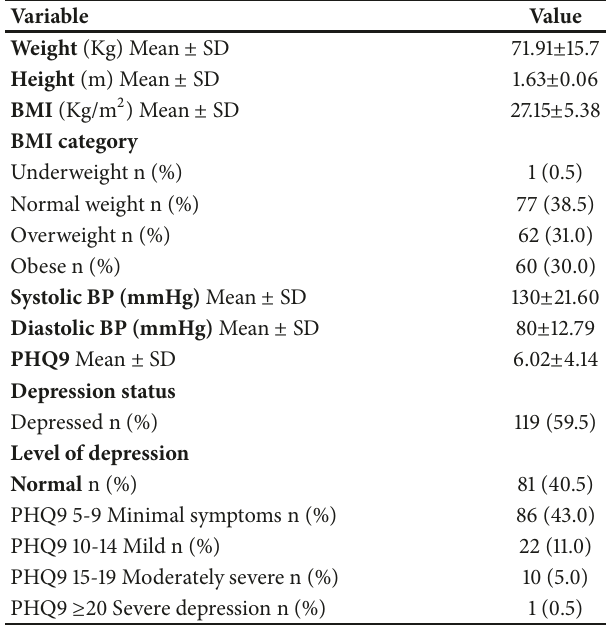
Table 2: Clinical characteristics of 200 study